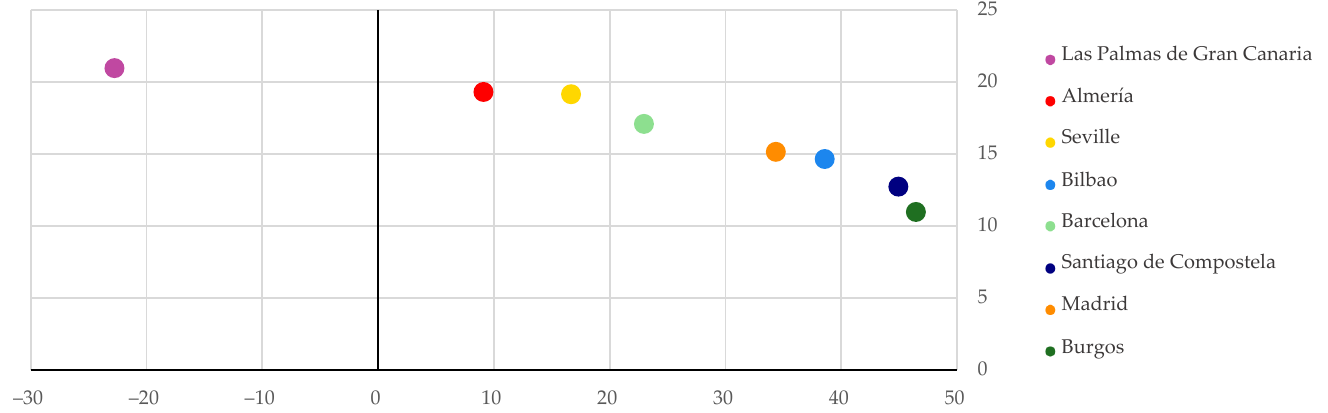
Figure 7. Total energy savings (%) of model B in relation to the reference model regarding heat losses by evapotranspiration (W/m 2 ) in each of the 8 cities.